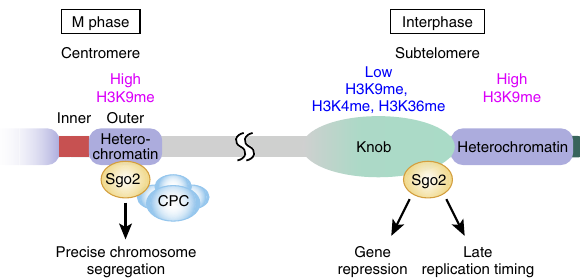
Figure 8 | Model of the multiple roles of Sgo2 during the cell cycle. During M phase, Sgo2 accumulates at the outer regions of the centromeres, where H3K9me is enriched and recruits CPC for precise chromosome segregation. In interphase, Sgo2 is enriched at the heterochromatin- adjacent region of the subtelomeres, where the levels of the histone modifications such as H3K9me, H3K4me and H3K36me are relatively low. Sgo2 is essential to form the knob structures and to repress both gene transcription and replication, to ensure proper gene expression and replication timing.